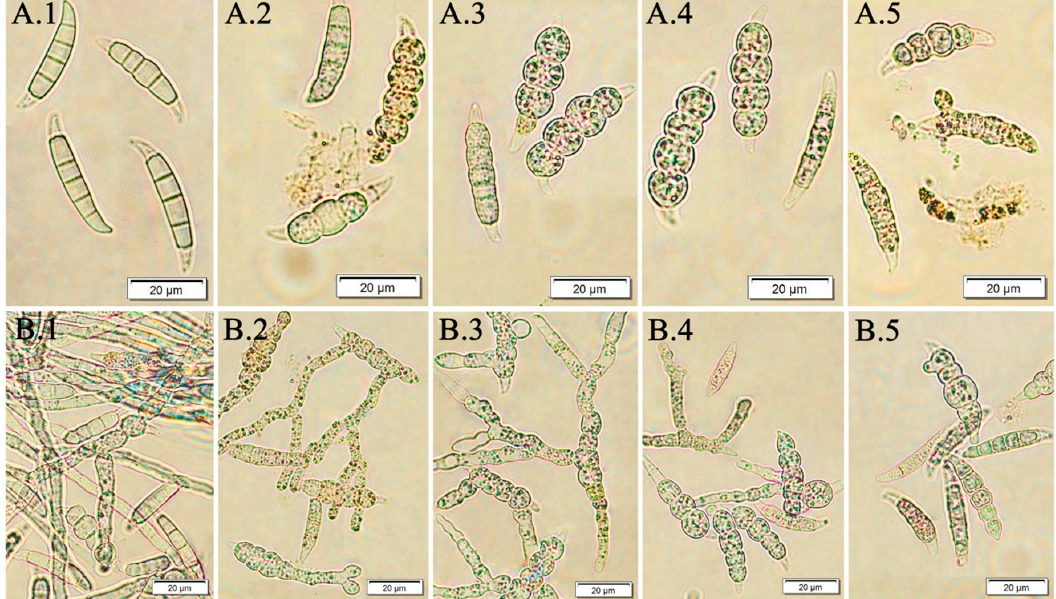
Figure 9. F. culmorum DEMFc37 non-germinated ( A ) and germinated ( B ) macroconidia treated with (1) 0.05%, (2) 0.2 %, (3) 0.5% and (4) 1.0% fucosterol after 120 h of incubation.